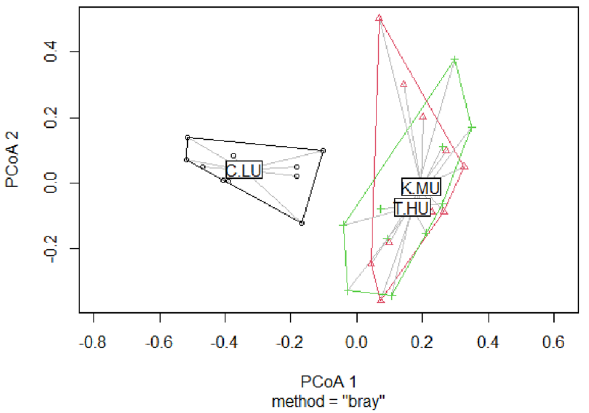
Figure 4. The MDS plot ordinates sites on community composition of dung beetles in the less urbanized (C.LU), moderately urbanized (K.MU) and highly urbanized (T.HU)